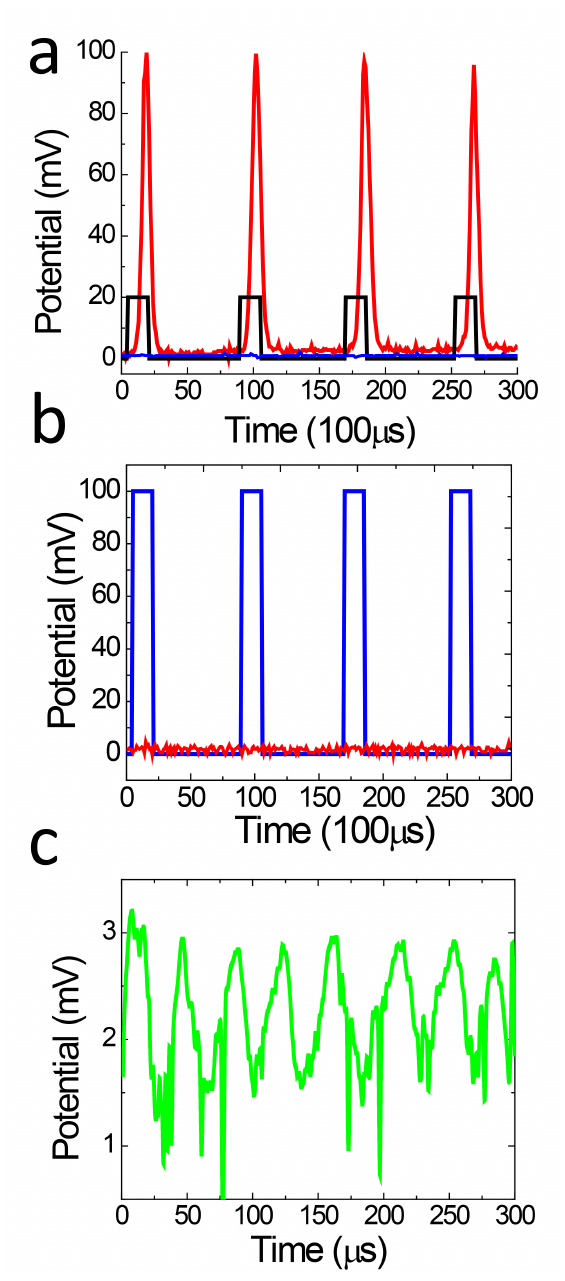
Fig.5. Electromagneticeditingofastreamofthenerveimpulse. (a)20 mVstreamofsub-thresholdpulsesappliedtotheneuronmembrane(black). Two output membrane readings are plotted with (red) and without (blue), applying an additional ac frequency. Here, 12 MHz + 35 MHz + 7 GHz + 13 GHz is a set of ac frequencies applied to the microtubule-neurofilament core using a coaxial probe inside an axon core. (b) Above threshold 97mV pulse stream is applied along with a set of ac frequencies (12 MHz + 35 MHz + 7 GHz+13GHz)tothemicrotubule-neurofilamentcore(blue). Thepotential response on the membrane is recorded by contacting the coaxial probe at Soma. (c) 5 µ m deep inside a coaxial axon probe is inserted, the natural potential fluctuation is recorded when there is no